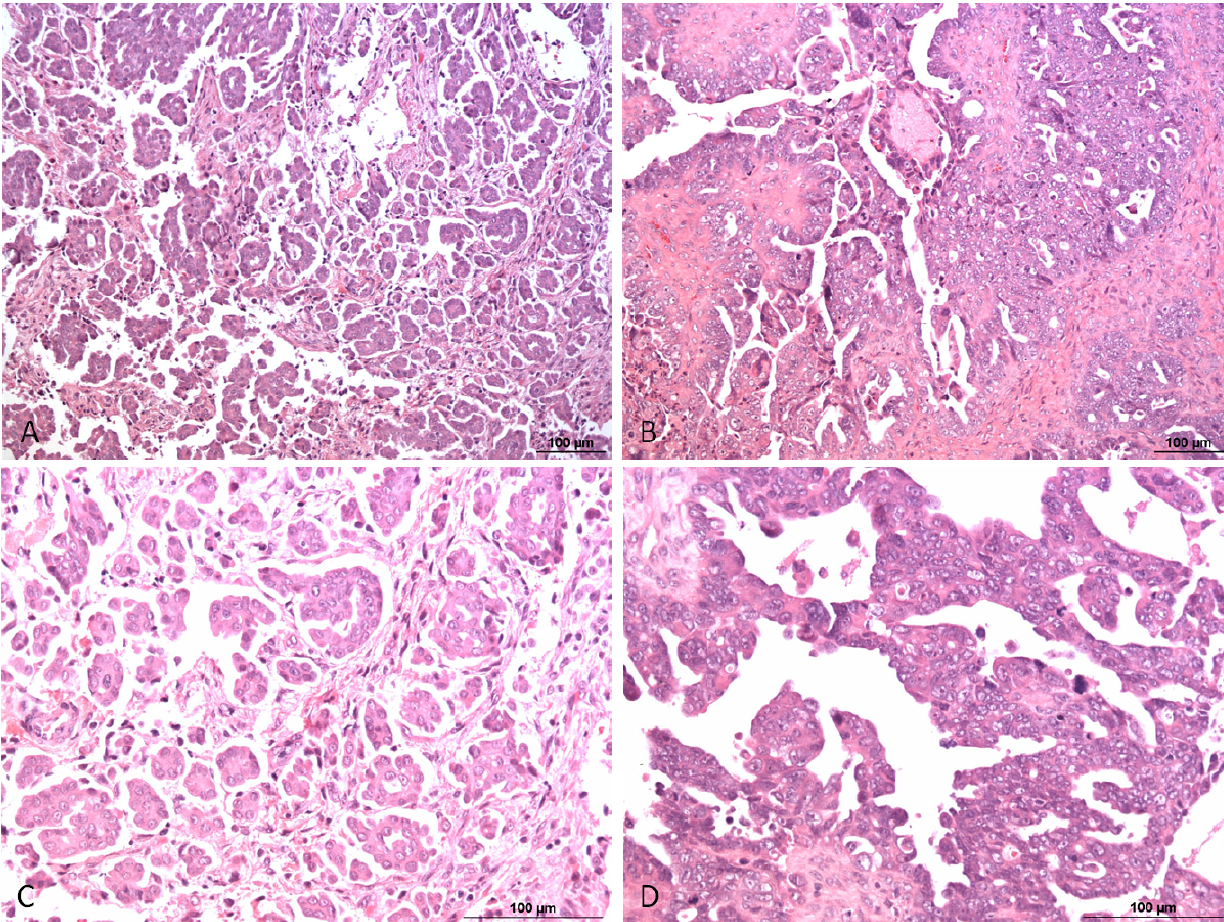
Figure 1. Type I/low grade ( A , C ) and type II/high grade ( B , D ) serous ovarian carcinoma. High grade serous carcinoma is characterized by a significantly higher degree of nuclear atypia and higher number of mitosis compared to low grade serous carcinoma. The papillae are less well preserved in high grade compared to low grade serous carcinomas. HE, 100× ( A , B ) and 200× ( C , D